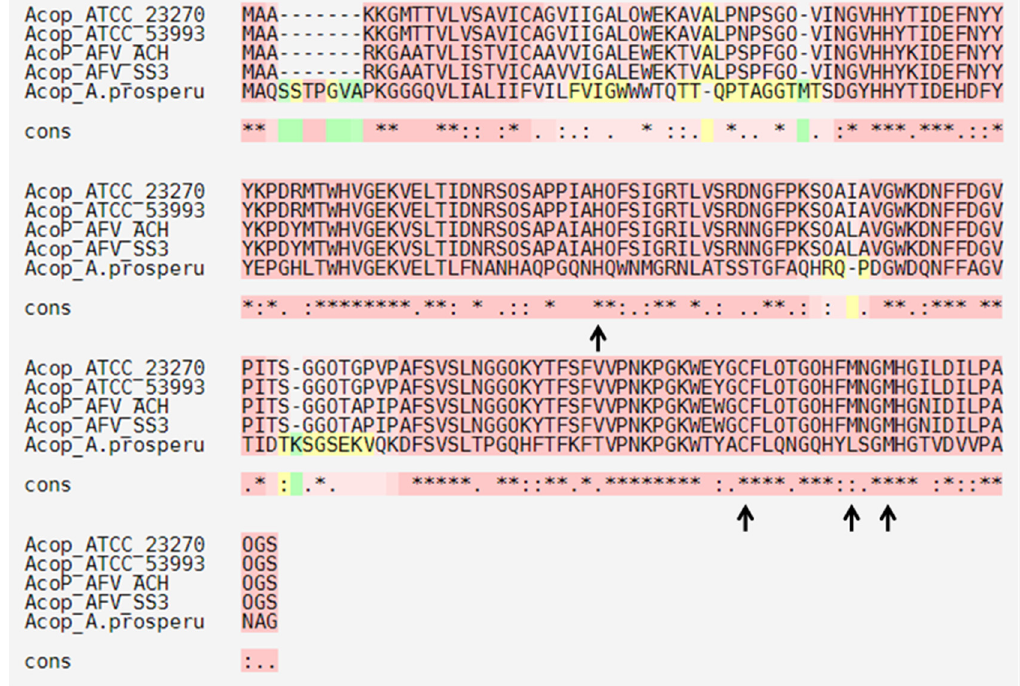
Figure 6. Amino acid sequence alignments of Acop proteins identified in different copper resistance microorganisms. Black arrows indicate the conserved H-C-H-M motif part of the type I copper-binding characteristic of cupredoxin proteins. ATCC_23270: A. ferrooxidans ATCC 23270; ATCC_53993: A. ferrooxidans 53993; AFV_SS3: A. ferrivorans SS3; AFV_ACH: A. ferrivorans ACH; and A.prosperu : Acidihalobacter prosperus